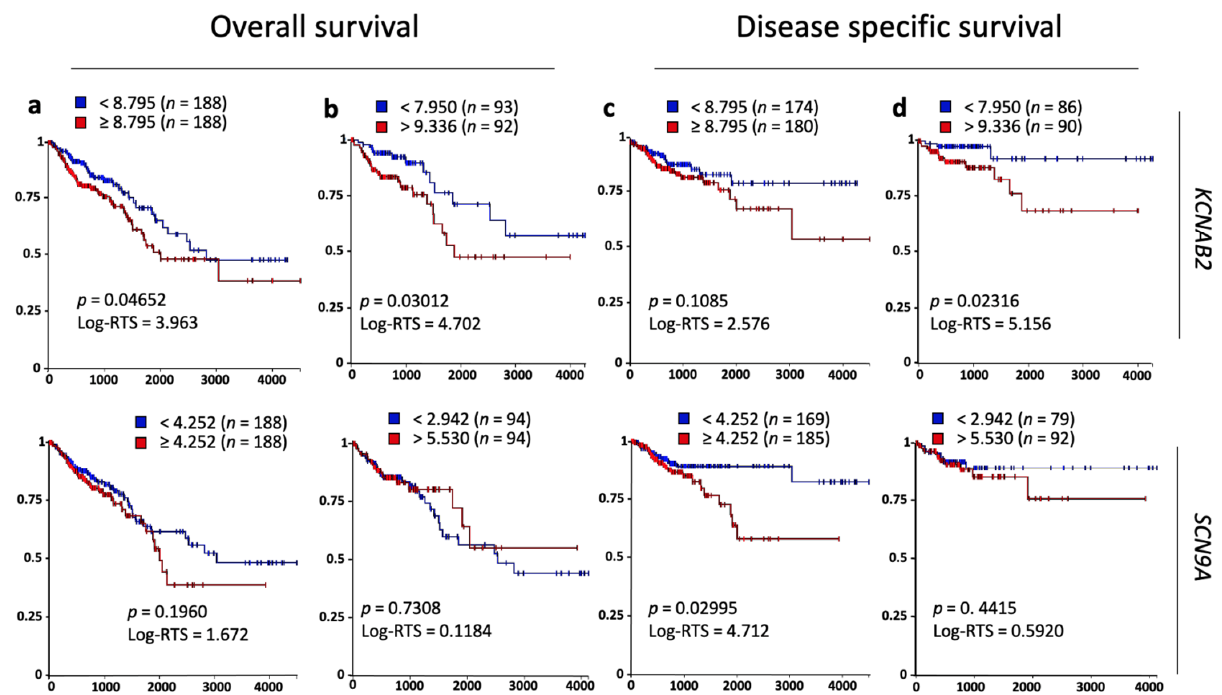
Figure 8. Kaplan–Meier survival analysis in CRC patients based upon KCNAB2 and SCN9A expression in primary colon tumors. Overall survival and disease-specific survival rates (defined in materials and methods) based on UCSC Xena Browser. Log-rank test (test statistics and p -value) using two groups of samples ( a , c ) or comparing upper and lower quartile ( b , d ). RNAseq–Illumina HiSeq gene expression of primary tumor samples ( n = 380 samples) from TCGA colon and rectal cancer (COADREAD) database. For simplicity, only two genes are included. The rest of the genes may be found in Figure S6.